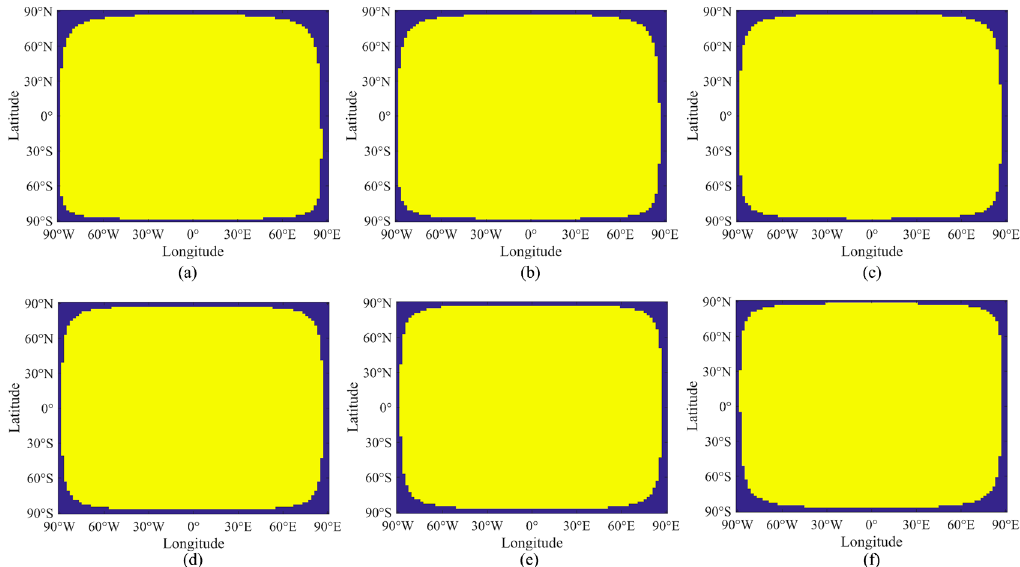
Figure 9. The area on the Moon where sensor equipped on can observe hemisphere of the Earth at ( a ) 00:00, ( b ) 04:00, ( c ) 08:00, ( d ) 12:00, ( e ) 16:00, and ( f ) 20:00 UTC on 1 January 2010. The blue part indicates a Moon-based platform at a position on the lunar surface where the Earth’s hemisphere cannot be observed. Conversely, the yellow part means that the Earth’s hemisphere is visible.